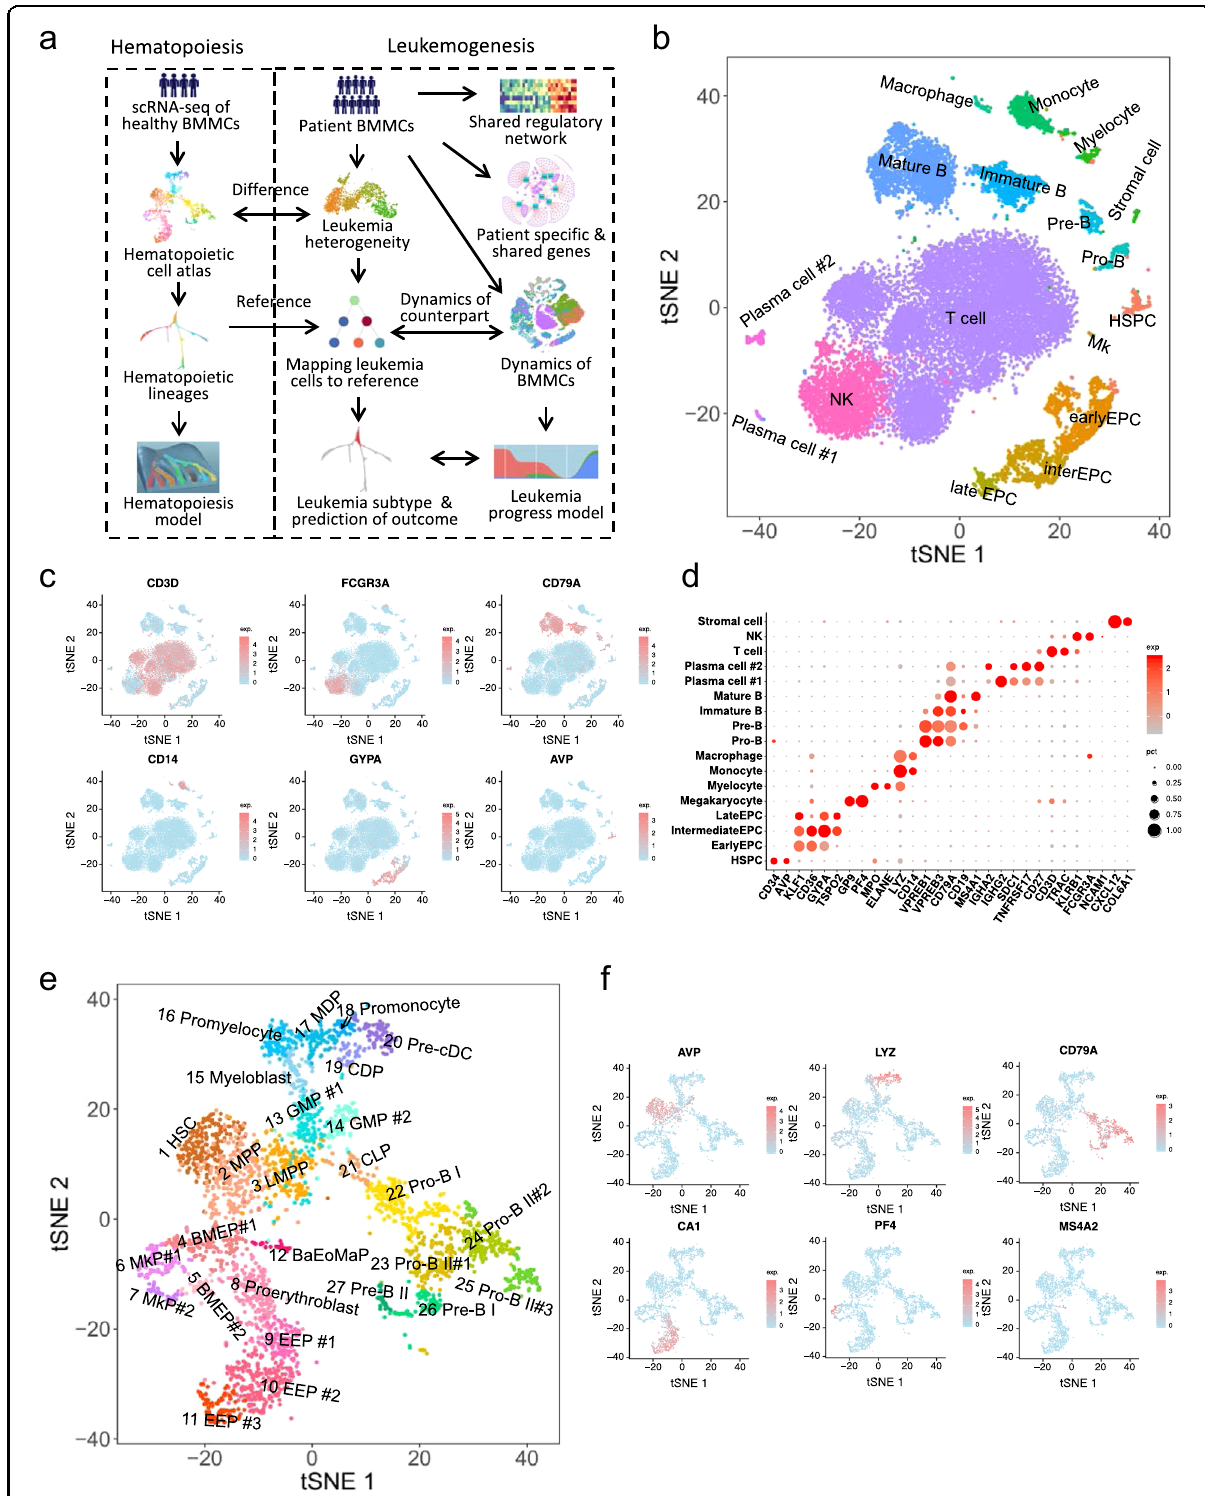
Fig. 1 The cell atlas of bone marrow mononuclear cells (BMMCs) and HSPCs (CD34 + ) cells in healthy individuals. a The schematic of this study. b tSNE projection of BMMCs, colored by inferred cell type. c tSNE projection of BMMCs with each cell colored based on their normalized expression of CD3D , FCGR3A , CD79A , CD14 , GYPA , and AVP , respectively. d Normalized expression level and expression percentage of the cell type- speci fi c genes in 17 cell populations in BMMCs. e tSNE projection of HSPCs (CD34 + ) cells, colored by inferred cell type. f tSNE projection of HSPCs with each cell colored based on their normalized expression of AVP , LYZ , CD79A , CA1 , PF4 , and MS4A2